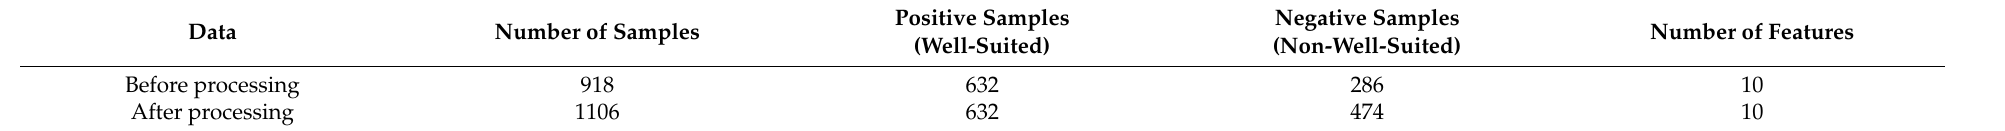
Table 6. Comparison of sample data